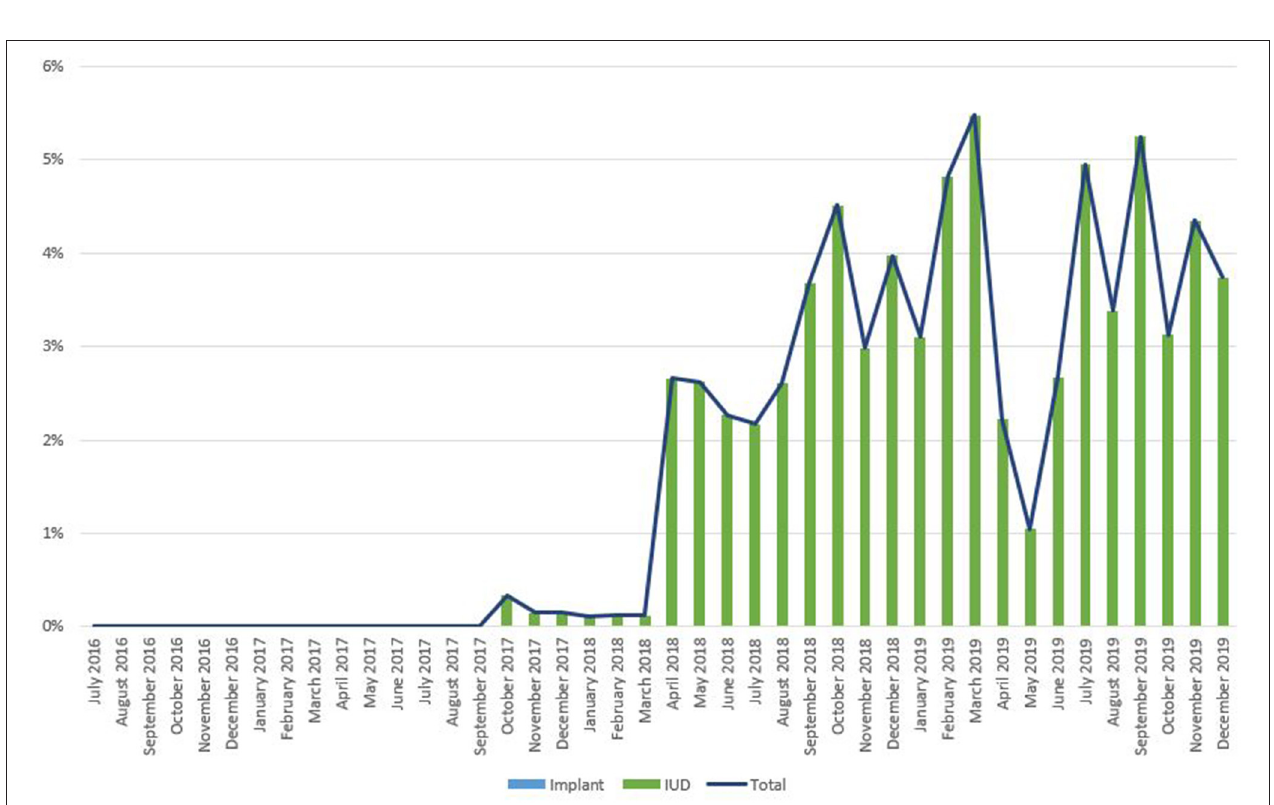
FIGURE 7 | Immediate postpartum IUD and implant uptake among all facility-based deliveries, July 2016-December 2019, Syria.